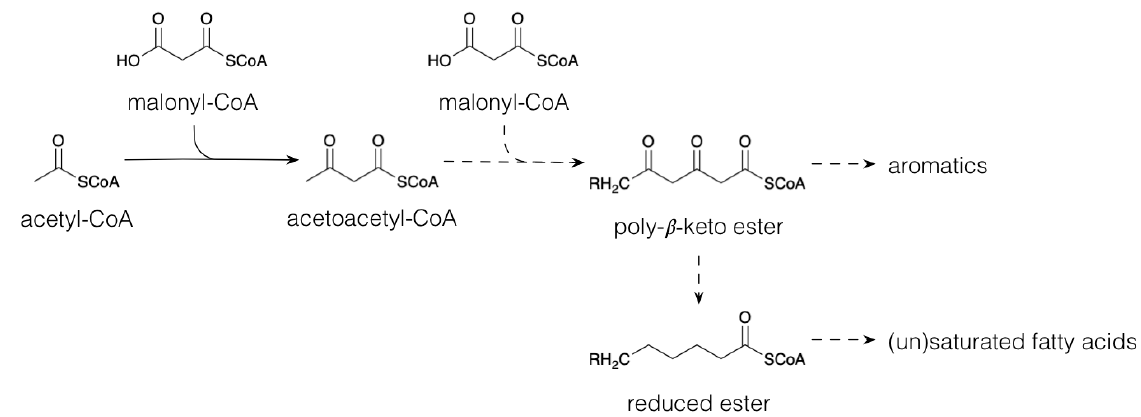
Figure 1. Biosynthesis of polyketides and (un)saturated fatty acids. Dashed arrows indicate multiple conversions.